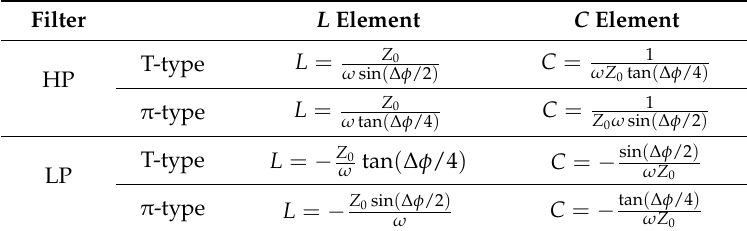
Table 1. Design equations for calculating the L and C elements of the LP/HP filter networks. Filter L Element